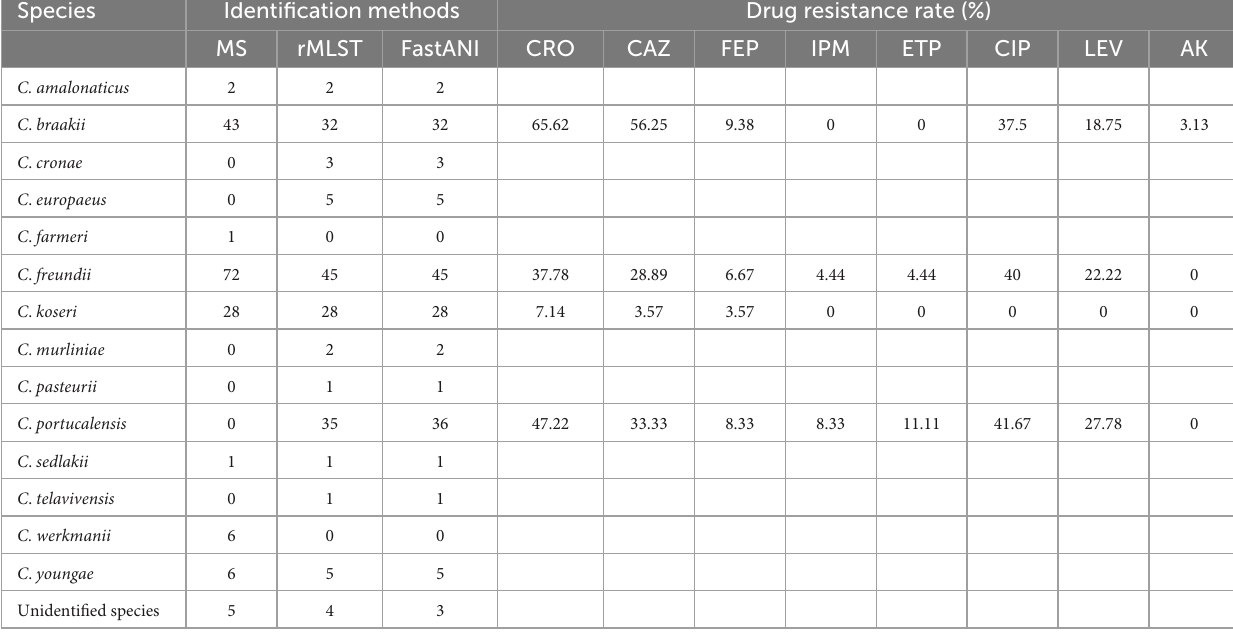
TABLE 1 The identification and drug resistance rate of Citrobacter spp.